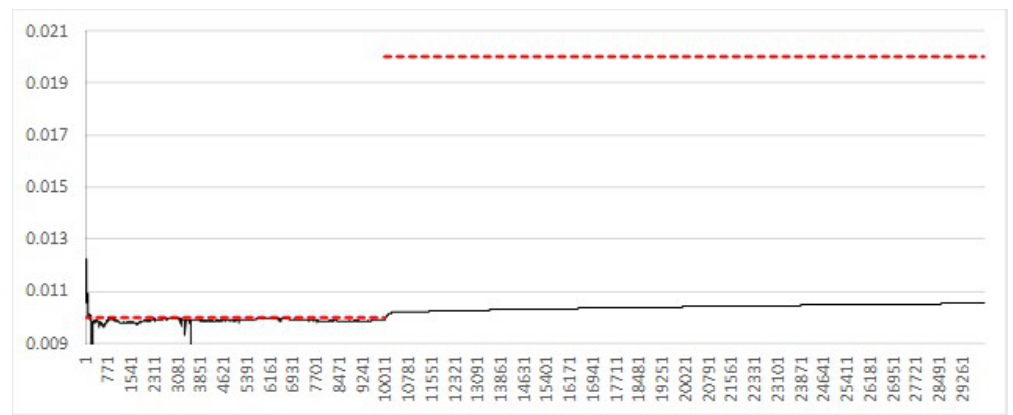
Figure 1. Estimated expected value (black) vs. simulation input value (red) of σ t with regime change after 10,000 steps for the Liu and West